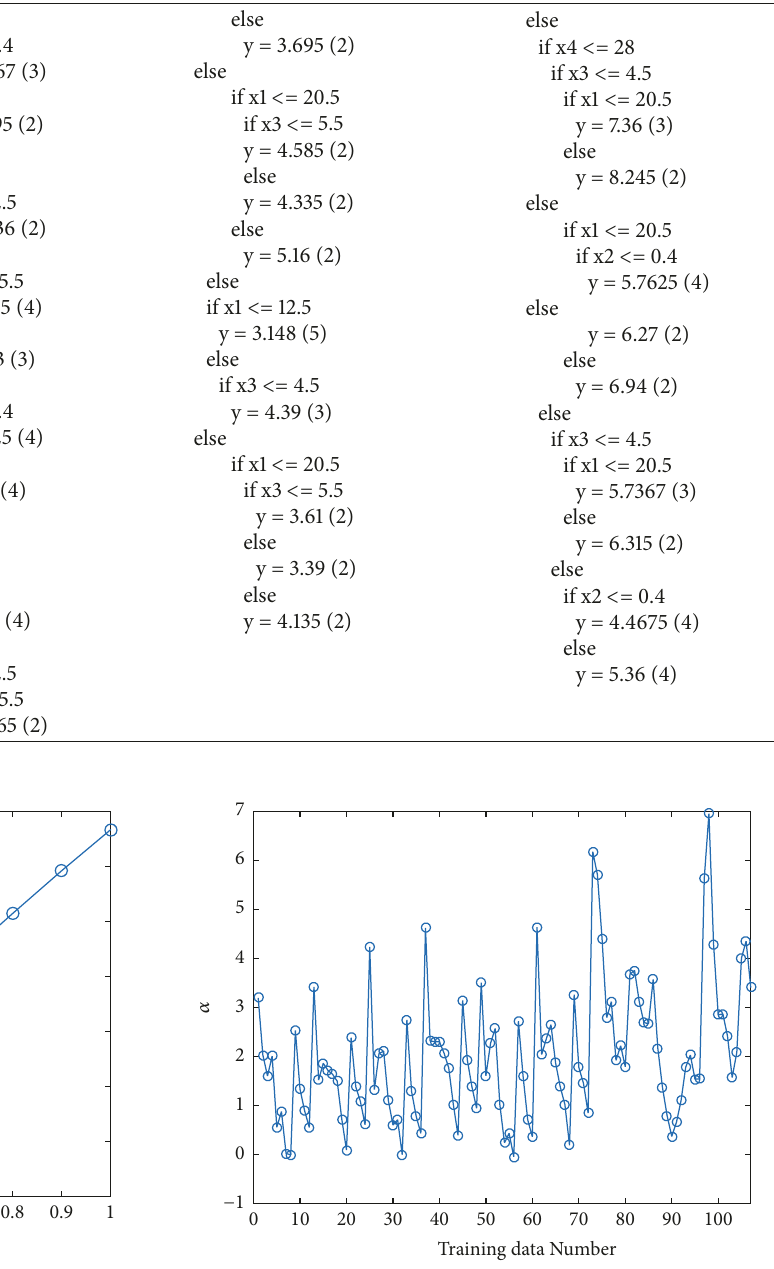
Figure 8: Lagrange multiplier vector for the SVR model.